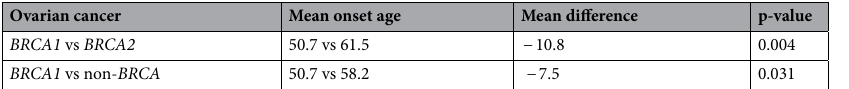
Table 6. Significant and trending differences in the mean onset of ovarian cancer.